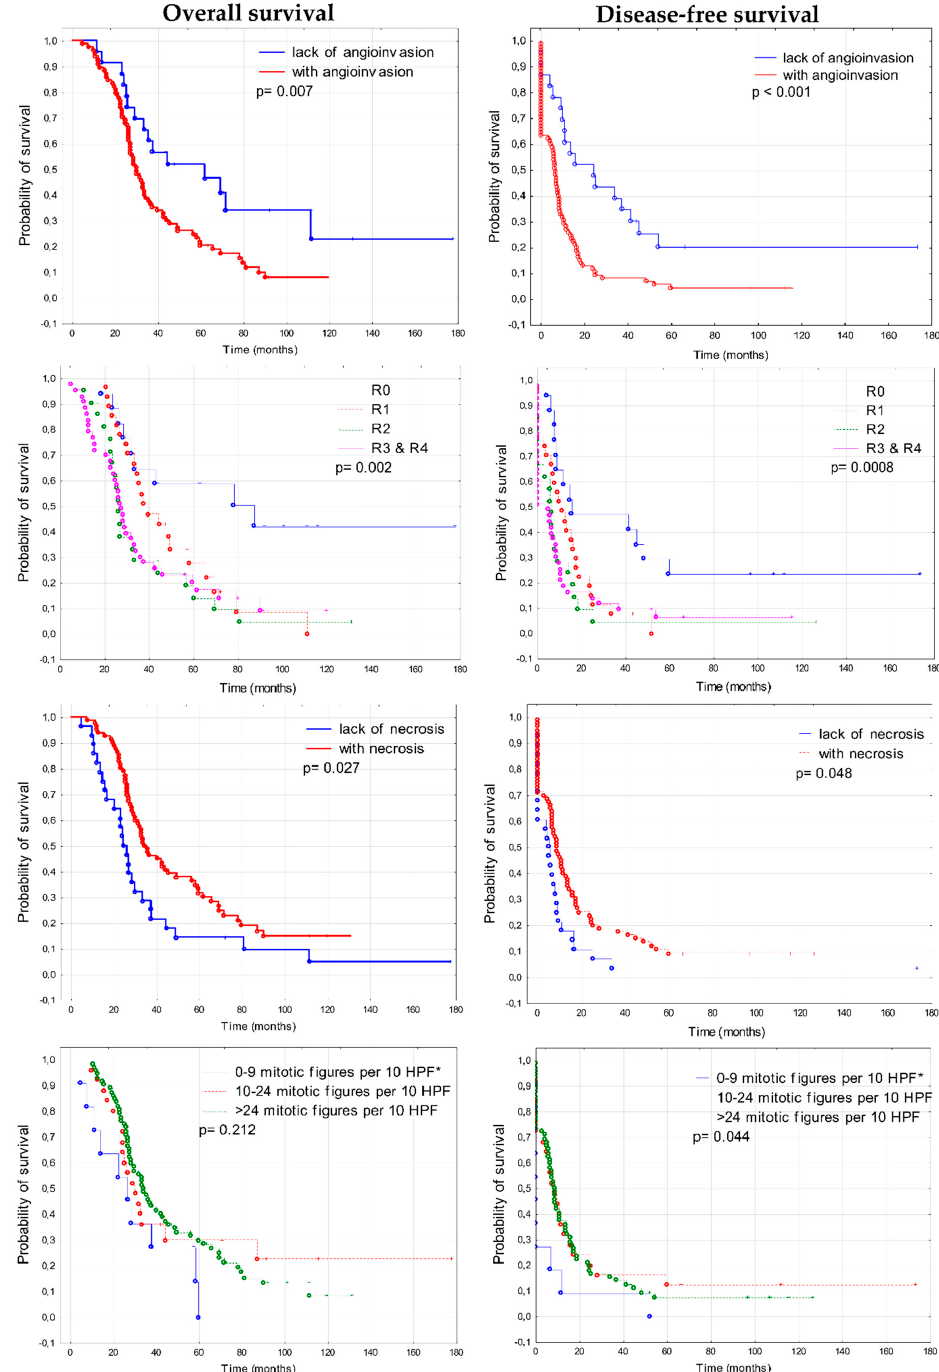
Figure 9. Kaplan–Meier analysis of overall survival (OS) and disease-free survival (DFS) in 108 ovarian cancer patients in relation to clinico-pathological features. * HPF—high power field; R—residual disease: R0 = 0 cm, R1 < 0.5 cm, 0.5 cm ≤ R2 < 2 cm, 2 cm ≤ R3 ≤ 5 cm, R4 > 5